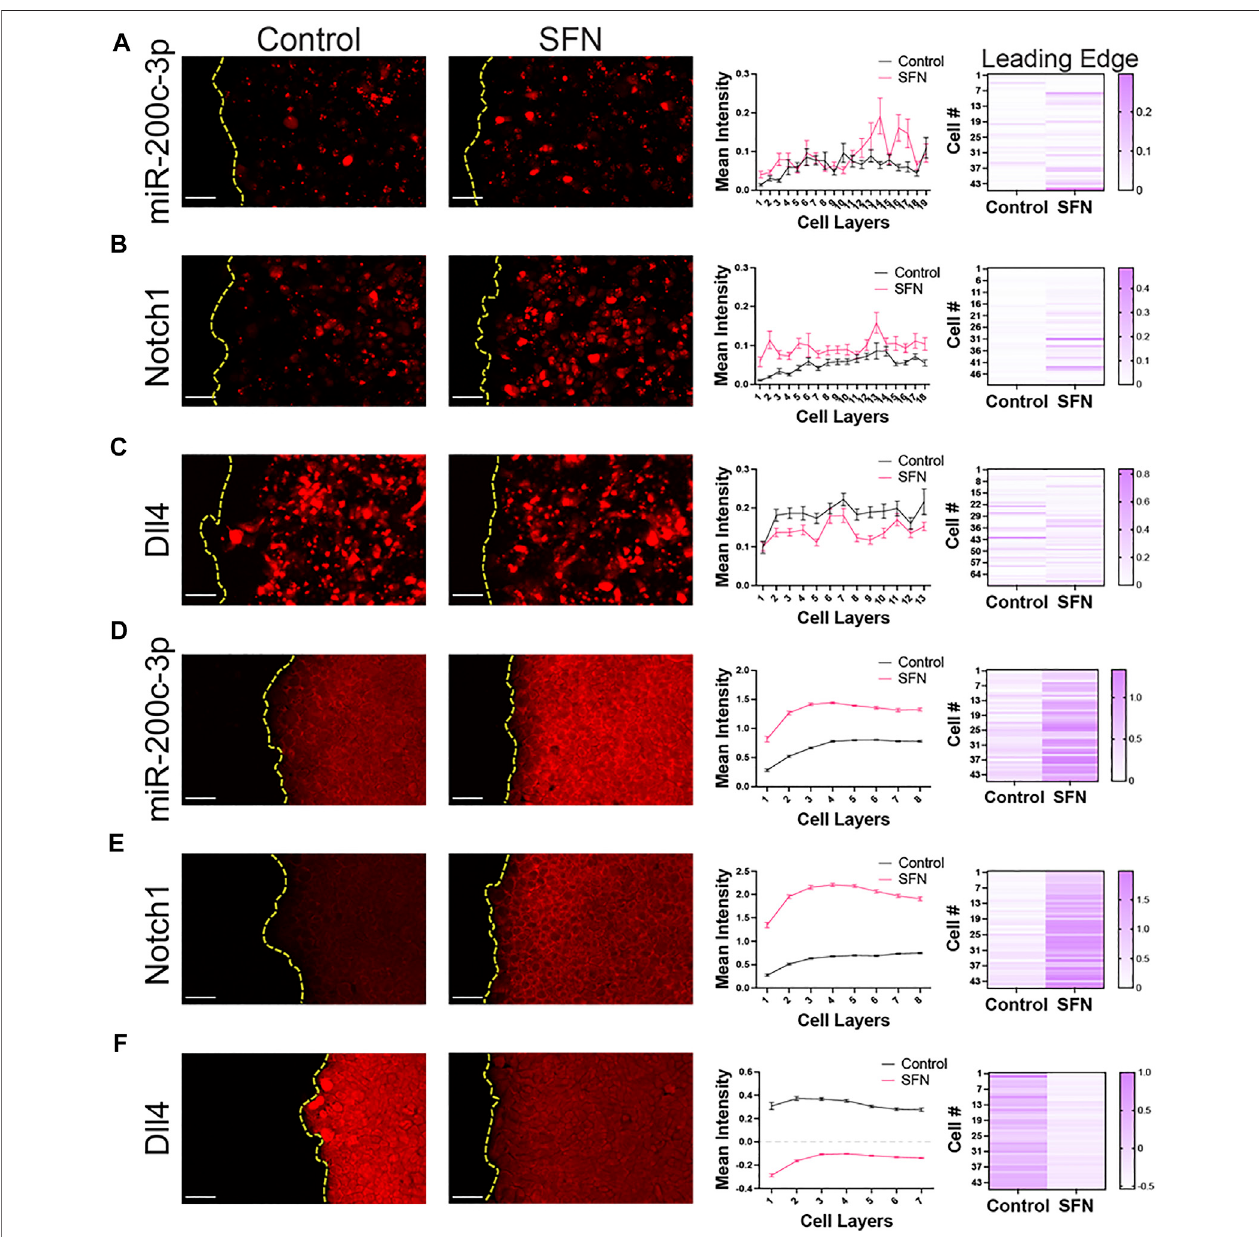
FIGURE 4 | Nrf2 upregulation modulates microRNA miR-200c-3p and Notch1 and Dll4 mRNA in the migrating front. (A – C) Live single cell gene expression measurements with the dsLNA probes in RT4 cells. From left to right: fl uorescence images of control and SFN (7.5 μ M, 24 h) cases, tracing of relative fl uorescence intensitypertissuedepthmeasuredasnumberofcelllayers,andheatmapofrepresentativecellsattheleadingedgemeasuring (A) microRNAmiR-200c-3p, (B) Notch1 mRNA, and (C) Dll4 mRNA levels in a cell migration assay. (D – F) FISH assay in fi xed RT4 cells. From left to right: fl uorescence images of control and SFN cases, tracing of relative fl uorescence intensity per tissue depth measured as number of cell layers, and heatmap of representative cells at the leading edge measuring (D) microRNA miR-200c-3p, (E) Notch1 mRNA, and (F) Dll4 mRNA levels in a scratch cell migration assay. Scale bars, 50 μ m. Each cell at the leading edge is indicated by “ Cell # ” where cell #1 refers to the fi rst measured cell from top to bottom. Data represent mean ± S.E.M. The two-way ANOVA with the post-hoc Tukey test was performed to compare across groups. At least 500 cells were analyzed for each condition (miRNA-200c-3p, Notch1 mRNA, and Dll4 mRNA). Results are from three experiments performed across different